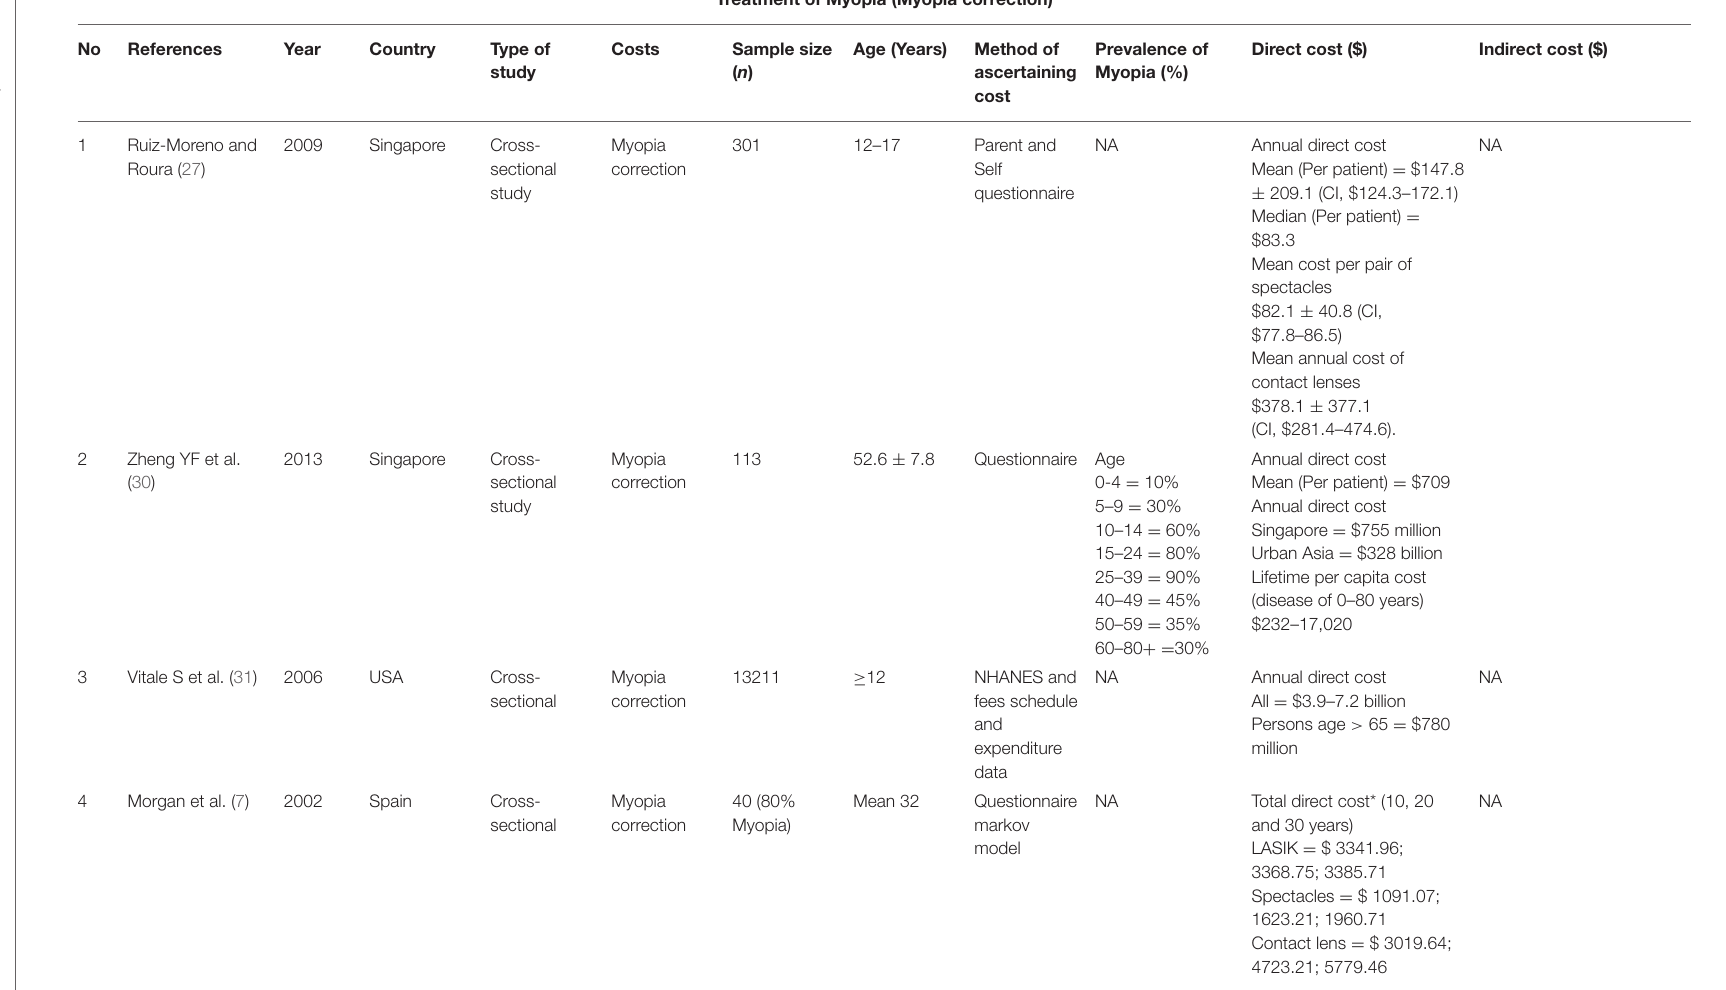
Treatment of Myopia (Myopia